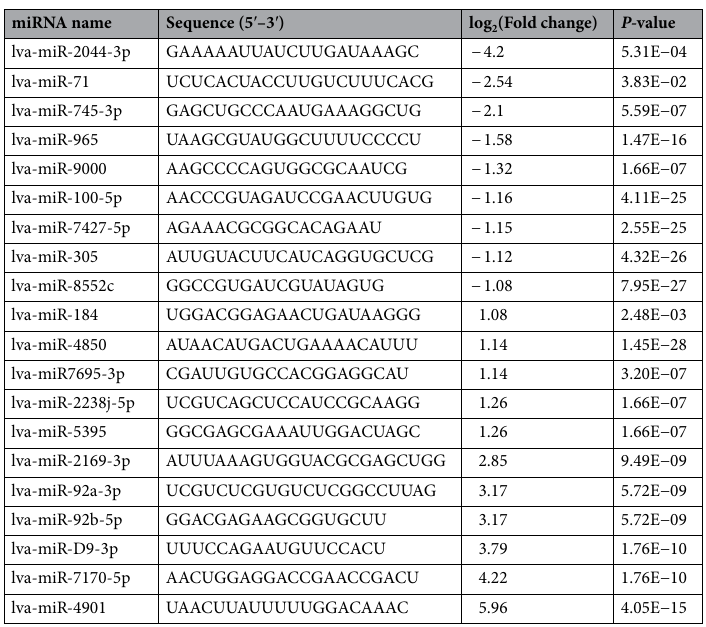
Table 1. Nucleotide sequences of differentially expressed miRNA homologs identified in VP AHPND -infected P. vannamei